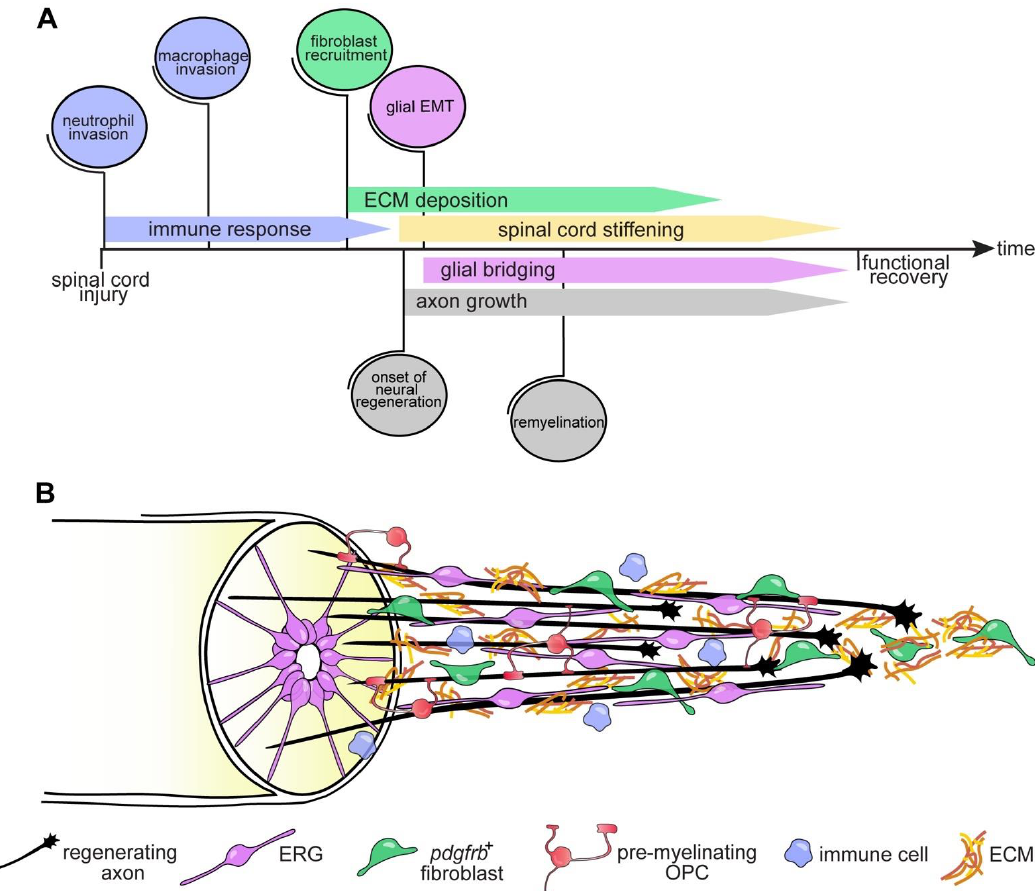
Figure 2. Cellular responses and events facilitating axon regeneration after SCI in zebrafish. An injury to the zebrafish spinal Fig. 2. Time course of the cellular Cellular responses and events facilitating axon regeneration after SCI in cord induces an immediate yet transient immune response mediated by activation of both resident microglia as well as zebrafish. invasion of peripheral neutrophils and macrophages. This is followed by the recruitment of pdgfrb + fibroblasts that deposit a growth-permissive ECM. Axons navigate the ECM-rich lesion environment. ERGs undergo an epithelial-to-mesenchymal transition (EMT) and participate in the formation of a neural tissue bridge that reconnects the severed spinal cord. Reactive OPCs differentiate into pre-myelinating OPCs that will remyelinate regrowing axonal fibres. The roles of individual reactive cells are described in detail in the main text. The sequence of events and the spatial relationship of major cellular components involved in axonal regrowth are summarized in ( A ) and ( B ), respectively. Note that no specific timepoints are given as the schematic view summarizes recent findings obtained from studies in larval and adult zebrafish. Abbreviations: EMT, epithelial-to-mesenchymal transition; ERG, ependymo-radial glia; pdgfrb + , platelet-derived growth factor receptor β -positive; OPC, oligodendrocyte progenitor cell; ECM, extracellular